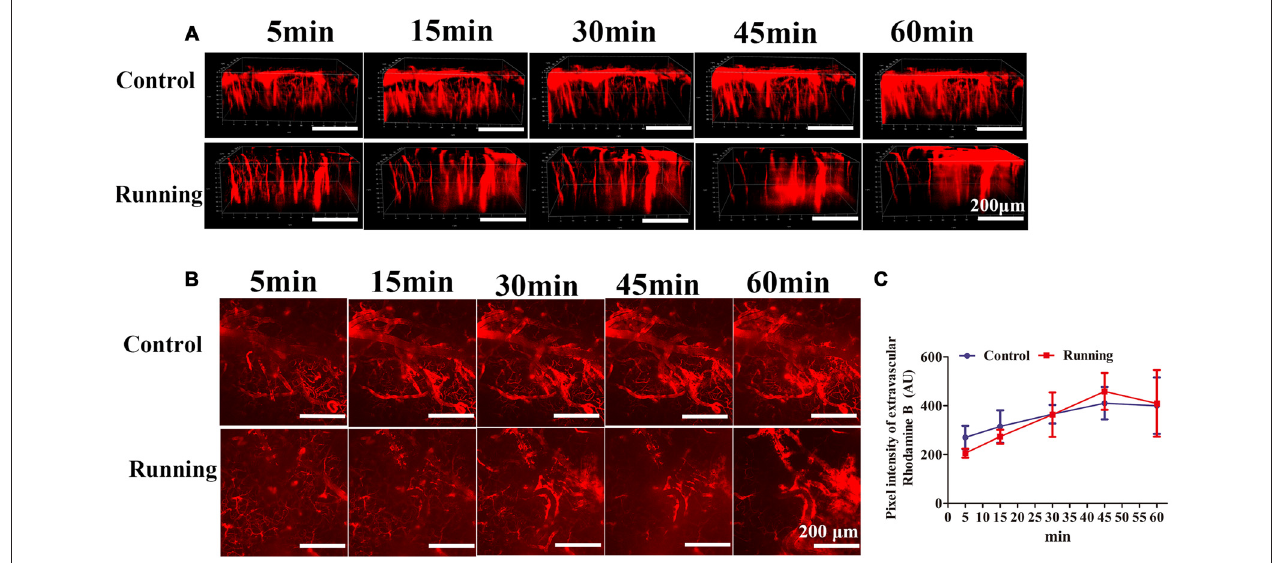
FIGURE 4 | Effects of voluntarily running on the permeability of the blood–brain barrier (BBB). (A) 3D reconstructed images of the brain vessels at different time points after rhodamine B was injected into the mouse tail vein. (B) xyz stacks of the brain vessels at different time points, indicating dye permeation. (C) Line diagram of the pixel intensity in the extravascular compartment. Datasets are expressed as means ± SD, n = 6.